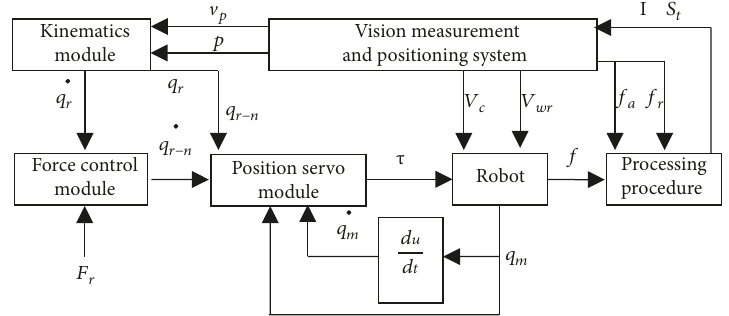
Figure 5: Robot grinding controller